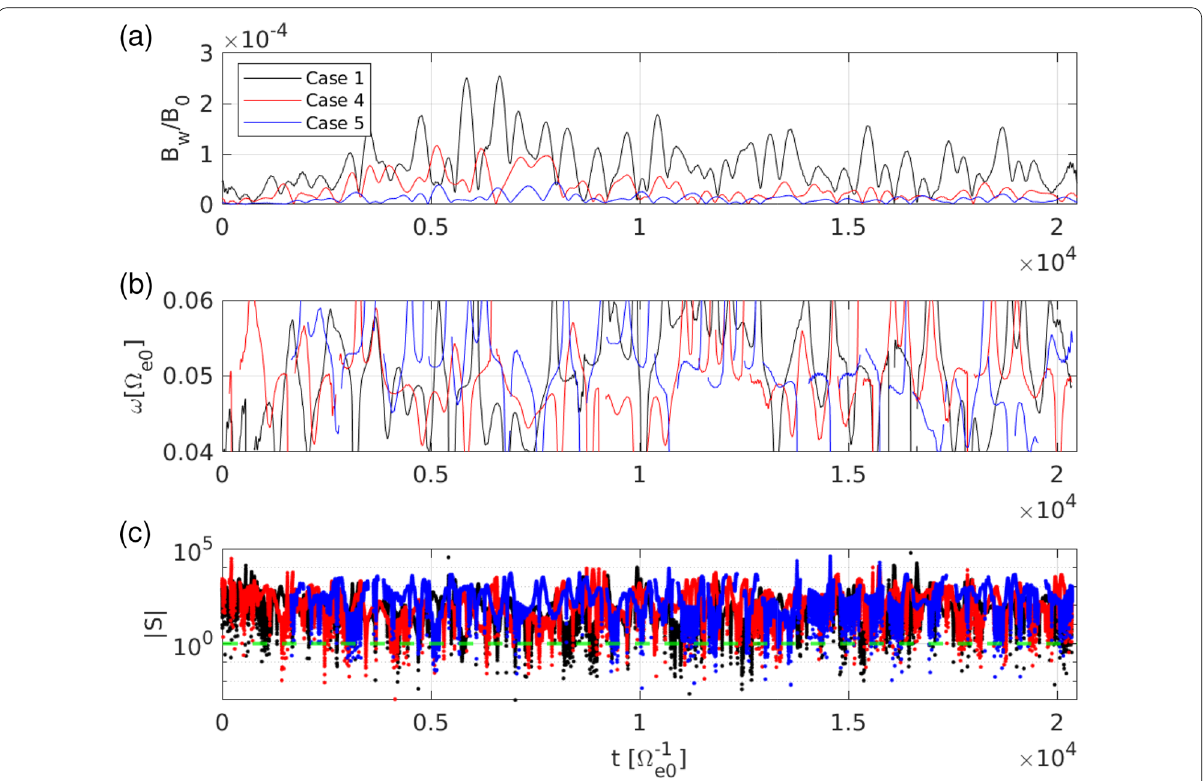
Fig. 13 a Wave amplitudes of forward-propagating waves ( t = 0 ∼ 2.04 × 10 4 [ (cid:31) − 1 e 0 ] ); b instantaneous frequencies, and c corresponding absolute S values in different cases of the hot electron density. Data with wave amplitudes less than 2 × 10 − 5 are eliminated. The green dashed line in c represents